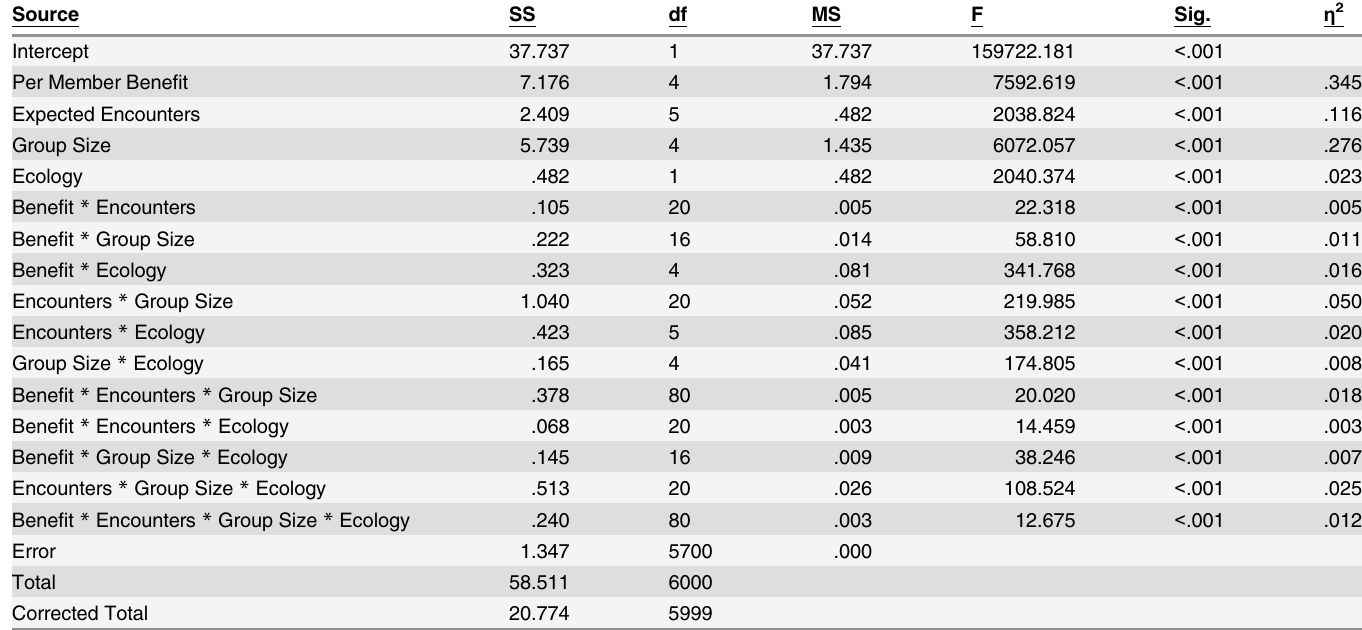
Table 1. GLM of Punish-Freeriding Probability .